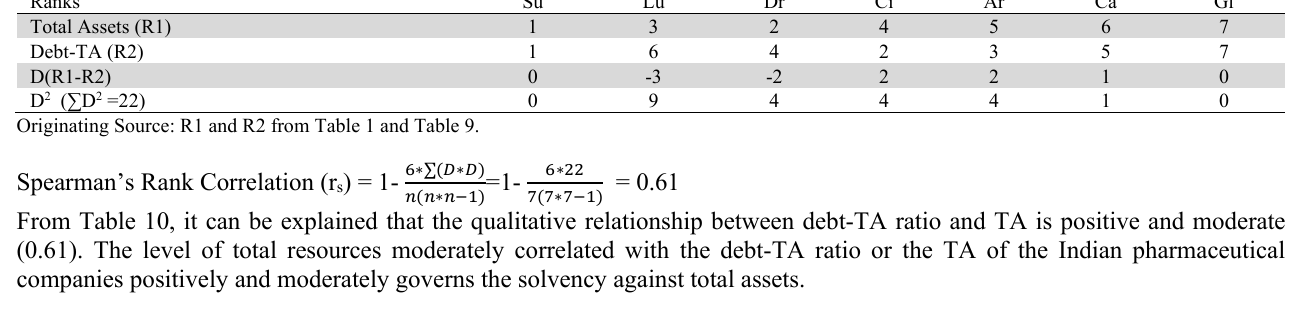
Table 9 explains that the total assets point of view the solvency of the Su, Ci, Dr, and Ar are satisfactory while Gl, Ca, and Lu is weaker, relatively. The relative correlation of the debt- TA ranks and firm size determinants (sales, TA, and WC) will explain the relationship of debt-equity ratio with each size determinants, individually. Qualitative relationship between Total assets and Debt- TA relationship of Indian Pharmaceutical firms Indian pharmaceutical companies Ranks Su